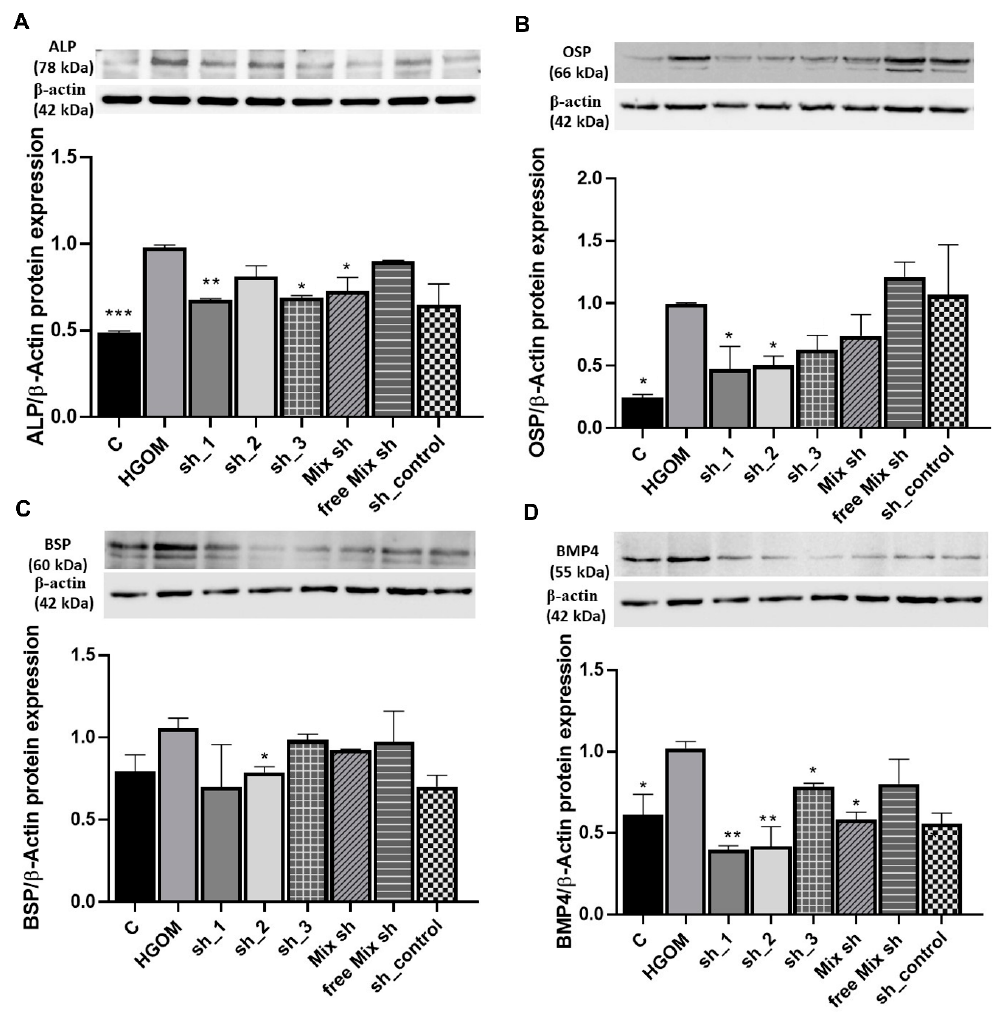
Figure 4. Down-regulation of Runx2 expression by C60-PEI/shRNA-Runx2 plasmids polyplexes reduces the expression of osteoblast di ff erentiation markers ALP ( A ), OSP ( B ), BSP ( C) and BMP-4 ( D ) in VIC exposed to HGOM. Results, normalized to β -actin, represent the means ± S.D. of three independent experiments performed in duplicate (n=6) and represent fold change relative to HGOM condition (considered as 1). Representative blots are shown above the graphs. *p<0.05, **p<0.01, ***p<0.001 versus HGOM.